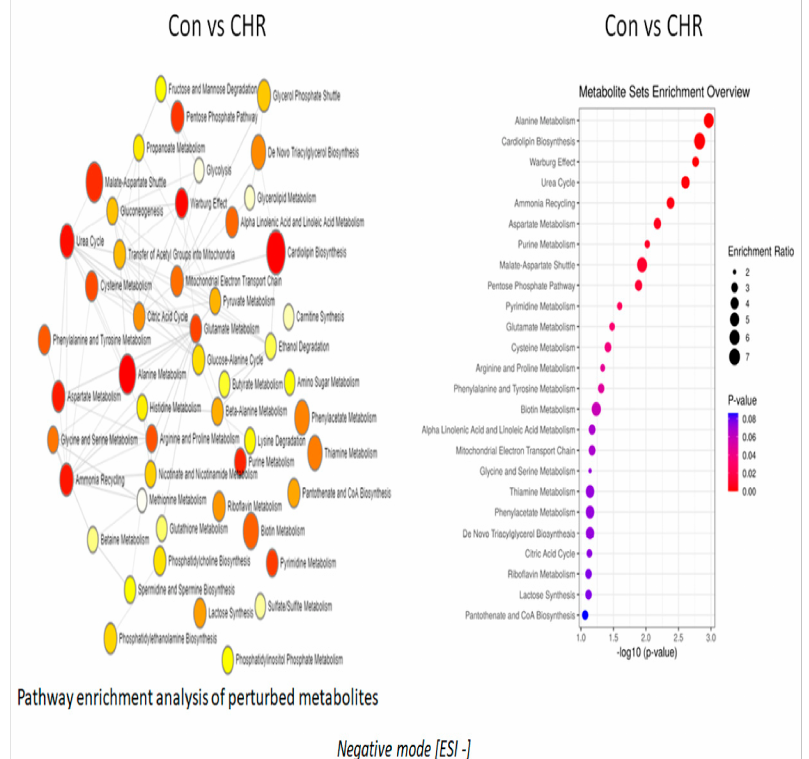
Figure 6. Metabolic pathways regulated by chrysin treatment in negative ion mode. The pathway enrichment analysis and enrichment ratio in the negative ion mode are illustrated in this figure.